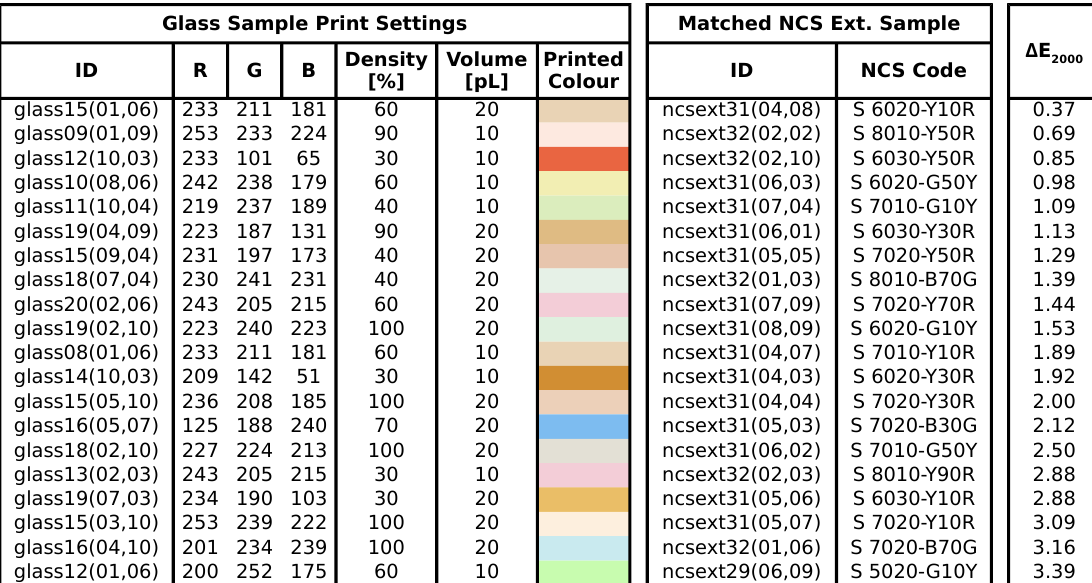
Table 2. 20 computed matches for a colour difference tolerance τ = 3.5, along with the printer settings for the glass samples and the corresponding NCS exterior set codes. These matches correspond to the upper 20 rows of Table 1, but the printed glass samples are shown here as the actual printed colours without